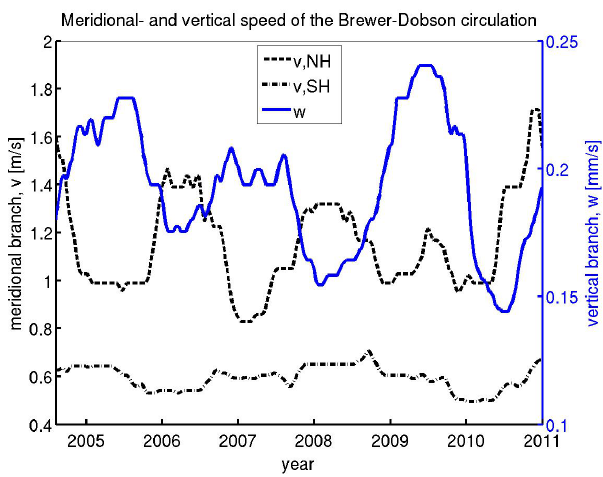
Fig. 4. Speed of the meridional branch of the BDC at 100hPa to the NH ( v , NH dashed black) and to the SH ( v , SH, dashdotted black) indicated on the left axis. The equatorial vertical ascent rate ( w , solid blue) at 68hPa is shown on the right axis. Speeds show a prominent ∼ 2yr oscillation related to the QBO. Both v , NH and w show interannual variability of about 21%. The vertical speed increases in phase with a meridional speed decrease and vice versa. The speed to the SH shows less variability and is out of phase with the NH for the most part, except for the first 3yr where they are correlated.